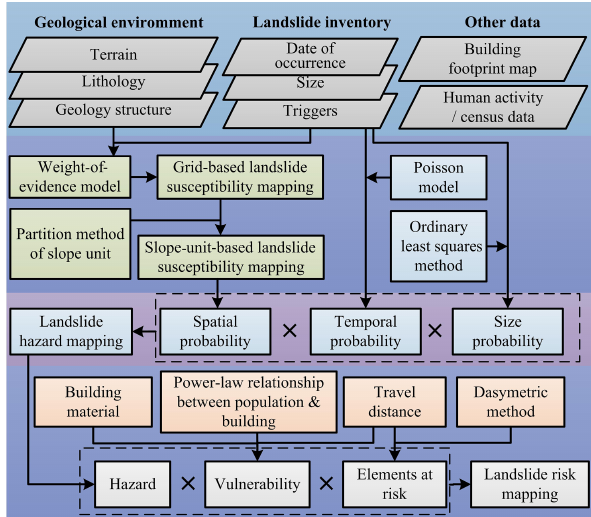
Figure 7. Flowchart of the methodology for landslide hazard risk